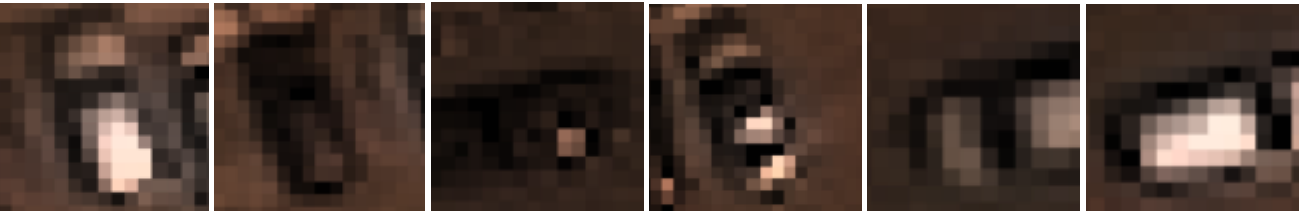
Figure 2. Different objects of the same class, “car”, from an aerial point of view could be considered as passing through various compositions of image augmentation, such as cropping, rotation, re-coloring, noise adding,